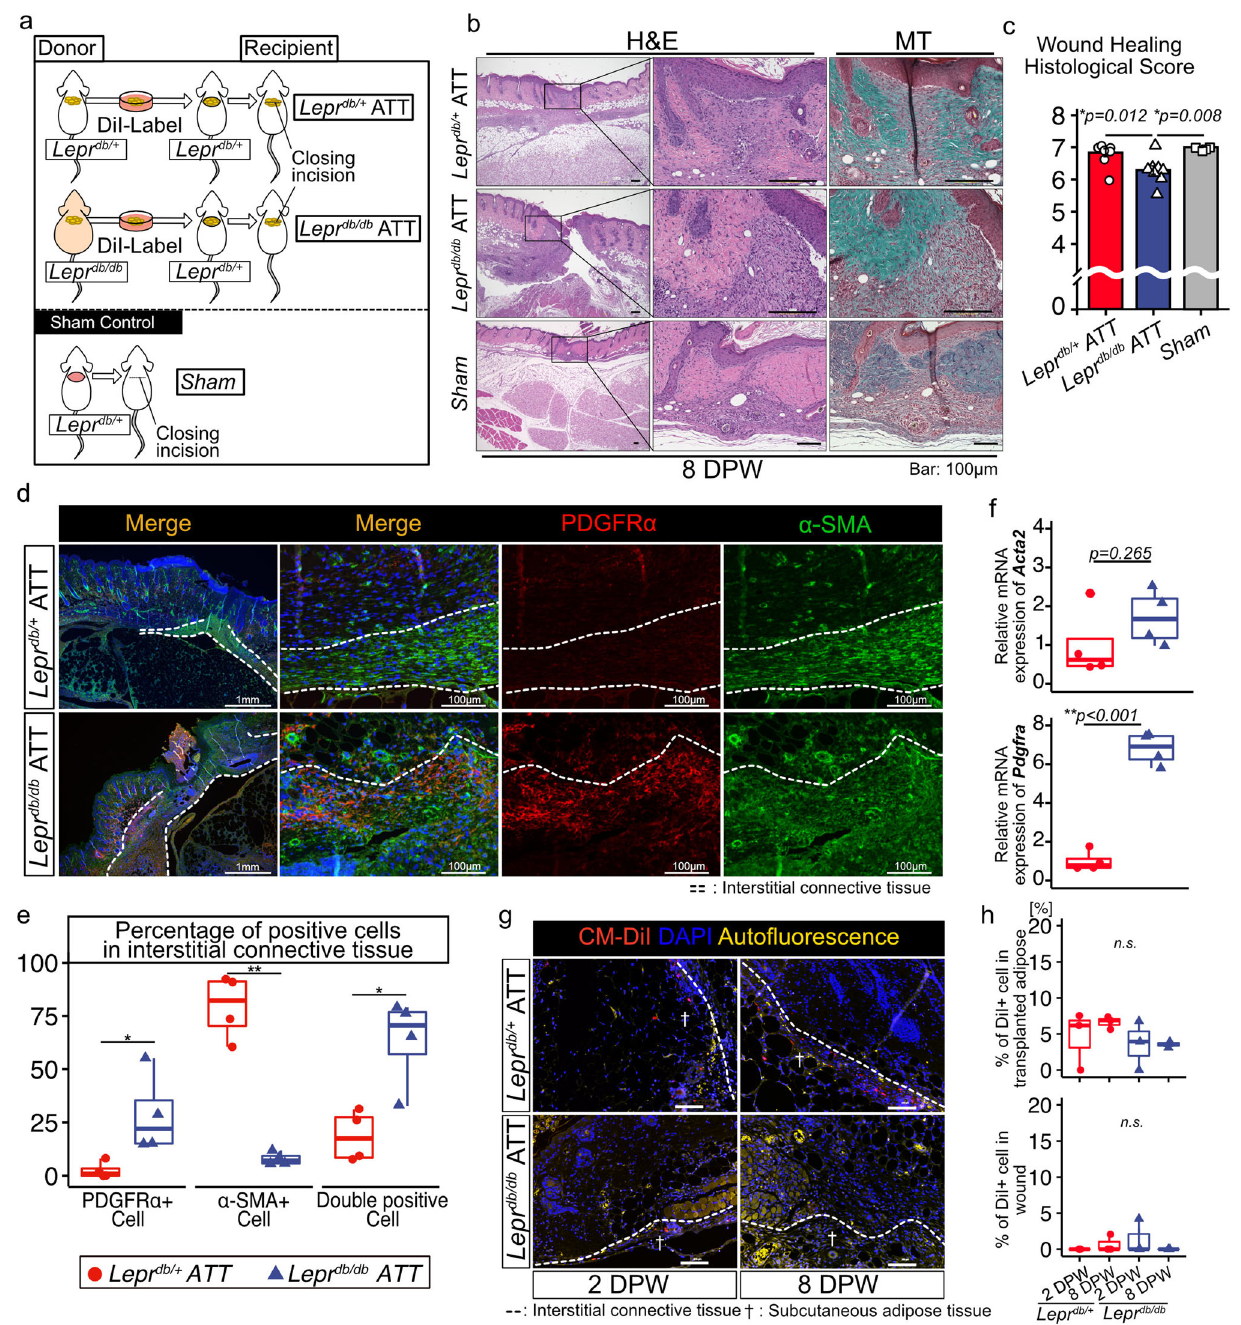
Fig. 2 Transplantation of adipose tissue derived from Lepr db/db mice into Lepr db/ + mice impairs wound healing. a Schematic diagram of the procedure for the adipose tissue transplantation (ATT) experiments. b Representative image of H&E staining and MT staining of a wound at 8 DPW and (c) the quantitative analysis of the wound healing histological score ( n = 8 in the ATT group and n = 4 in the sham group). d , e Representative images of PDGFR α and α -SMA immunostaining of a wound edge at 8 DPW and quantitative data on the percentage of PDGFR α and α -SMA + cells in interstitial connective tissue ( n = 4 for each group). f Relative levels of Acta2 and Pdgfra mRNA in Lepr db/ + and Lepr db/db mouse skin at 8 DPW. g , h Localization of CM- DiI – labeled adipose tissue – derived cells within wound regions and quantitative data ( n = 3 for each group). Quantitative data are shown as means ± SE in either dot plots or box-and-whisker plots with IQRs and 1.5 times the IQR. p -values were determined using a two-tailed Student ’ s t-test or the Tukey method for one-way ANOVA (* p < 0.05 and ** p <